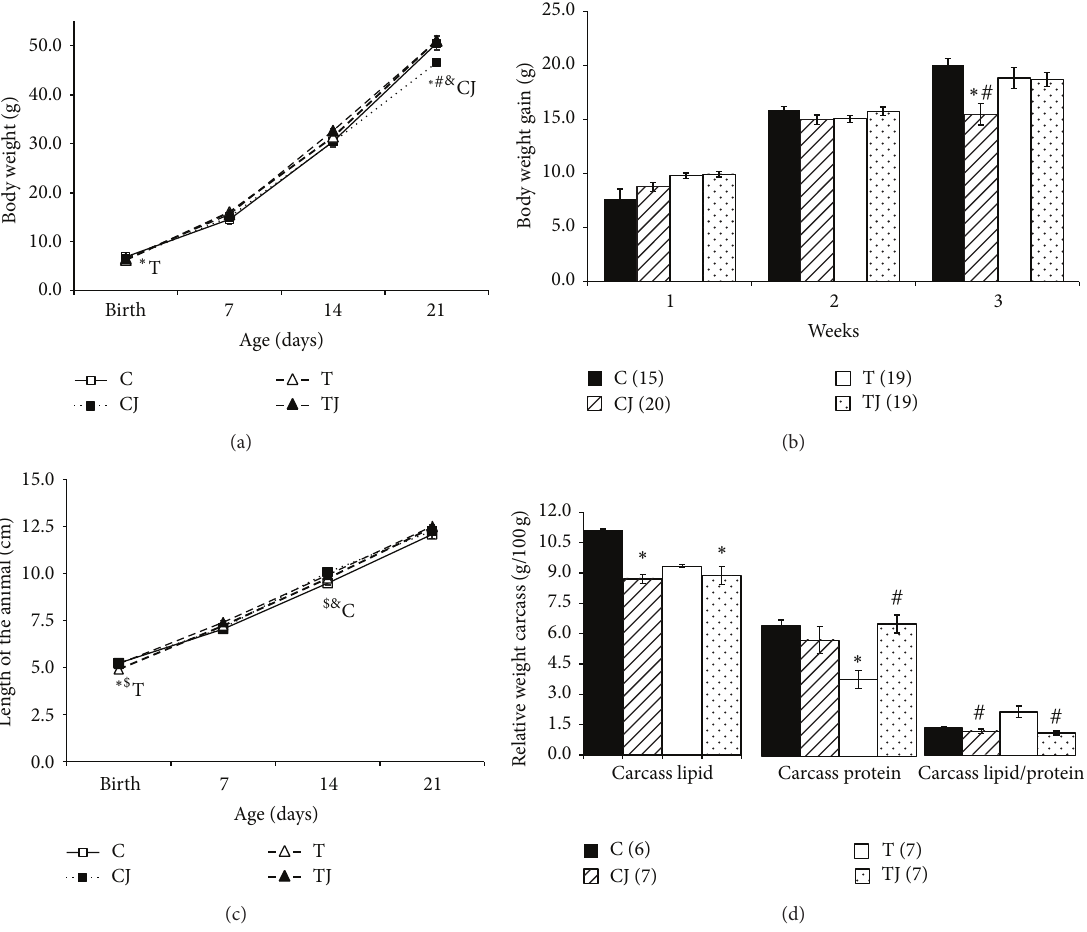
Figure 1: Body weight (a), body weight evolution (b), length (c), and carcass lipid, protein content, and lipid/protein ratio (d). C: offspring of dams fed control diet; CJ: offspring of dams fed control diet supplemented with 0.5% freeze-dried Jussara powder; T: offspring of dams fed diet enriched with hydrogenated vegetable fat, TFAs; TJ: offspring of dams fed diet enriched with TFAs supplemented with 0.5% freeze-dried Jussara powder. Data are means ± SEMs. The number in parentheses refers to the sample value. ∗ 𝑃 < 0.05 versus C. $ 𝑃 < 0.05 versus CJ. # 𝑃 < 0.05 versus T. & 𝑃 < 0.05 versus